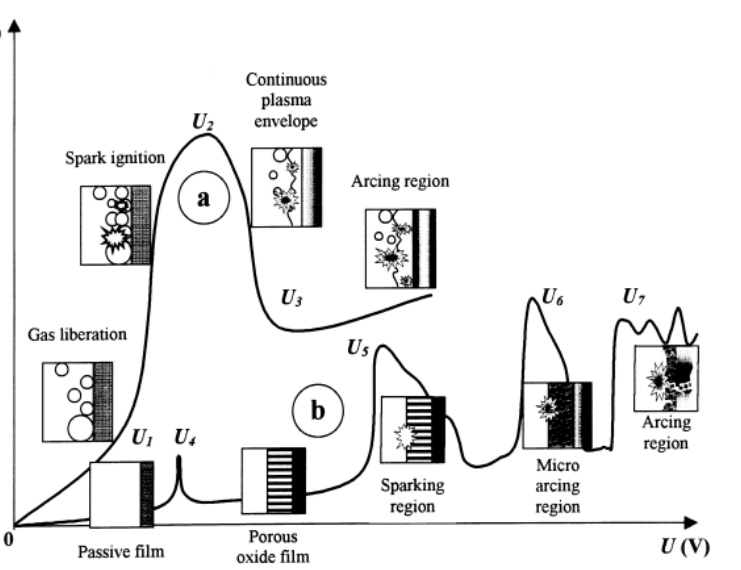
Figure 6. Current-voltage curves when the discharge phenomenon is observed near the surface of the electrodes ( a ) and in the oxide layer at the surface of the electrodes ( b